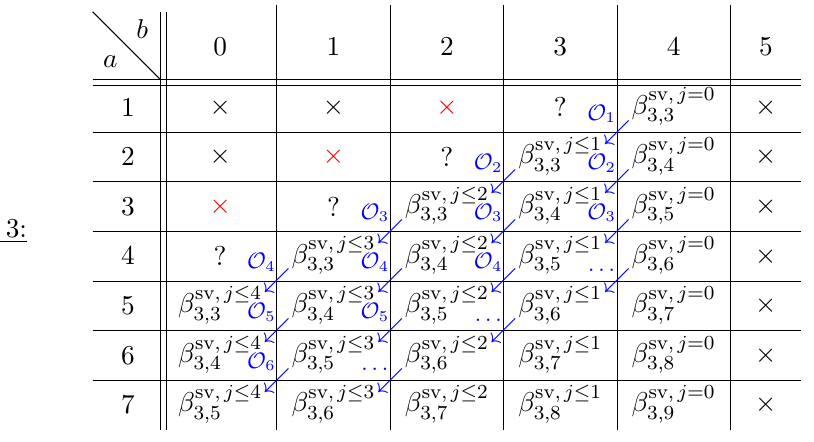
(6 , 0 b ) , together with 0